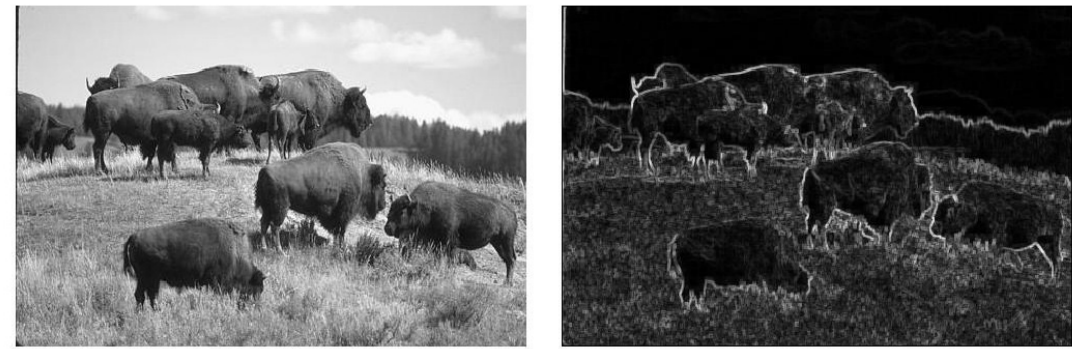
, m − L n , m T M , T P S M , S P